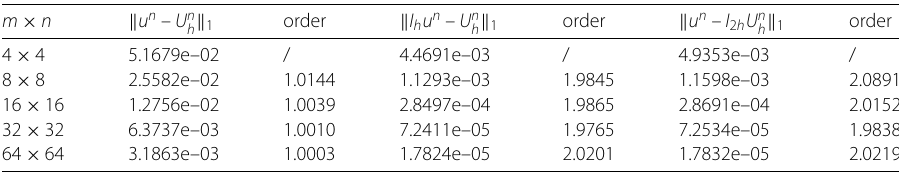
Table 4 Numerical results of u at t = 1.0